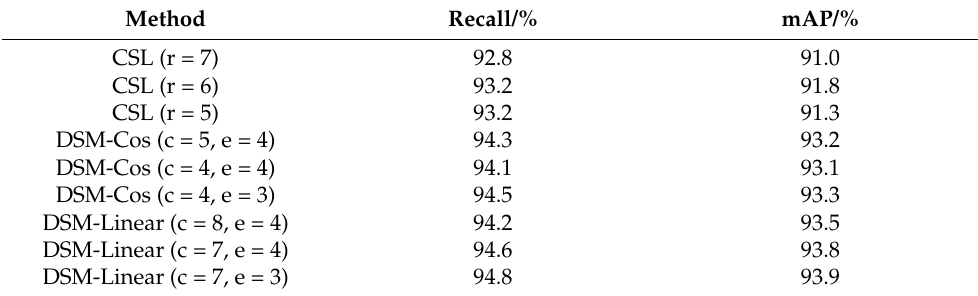
Table 6. Comparison of dynamic smoothing and the circular smooth